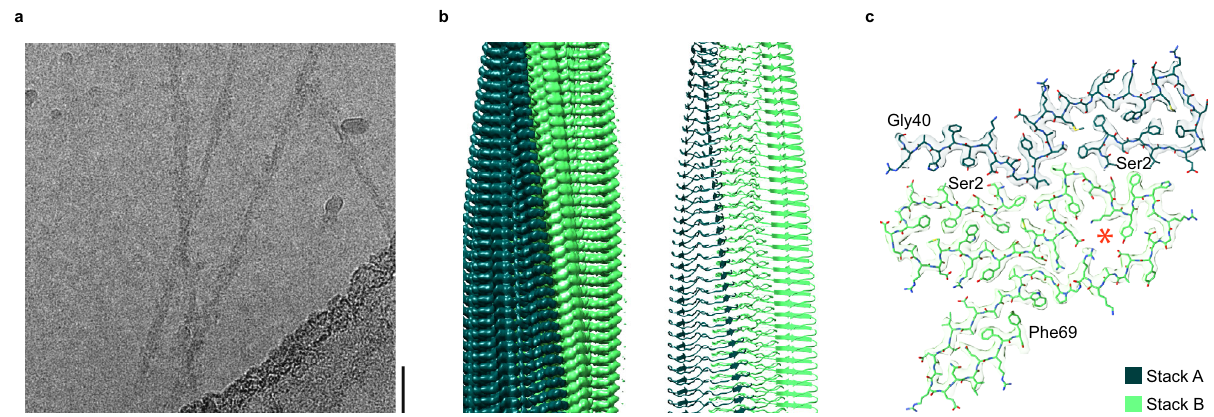
the molecular model (stick representation). The fi rst and the last residue of the model are indicated. Red asterisk: structural cavity. The two protein stacks corre- sponding to chains A and B of the fi bril protein are color coded in panels b , c , as indicated in panel c . Source data are provided as a Source Data fi le.